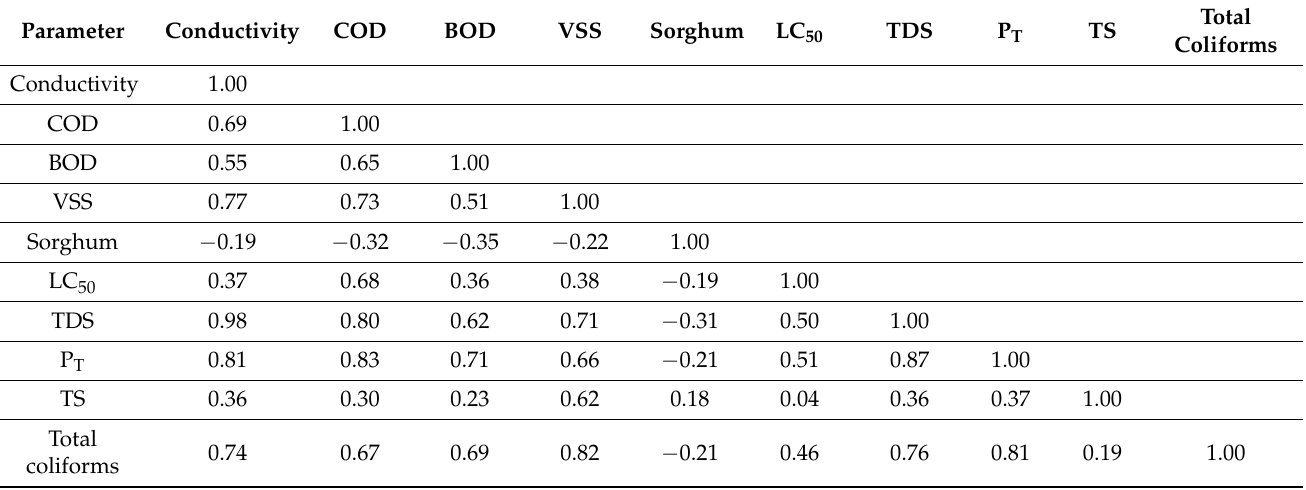
Table 4. Spearman’s rank correlation coefficient for physicochemical parameters and bioassays in the El Pueblito River sample